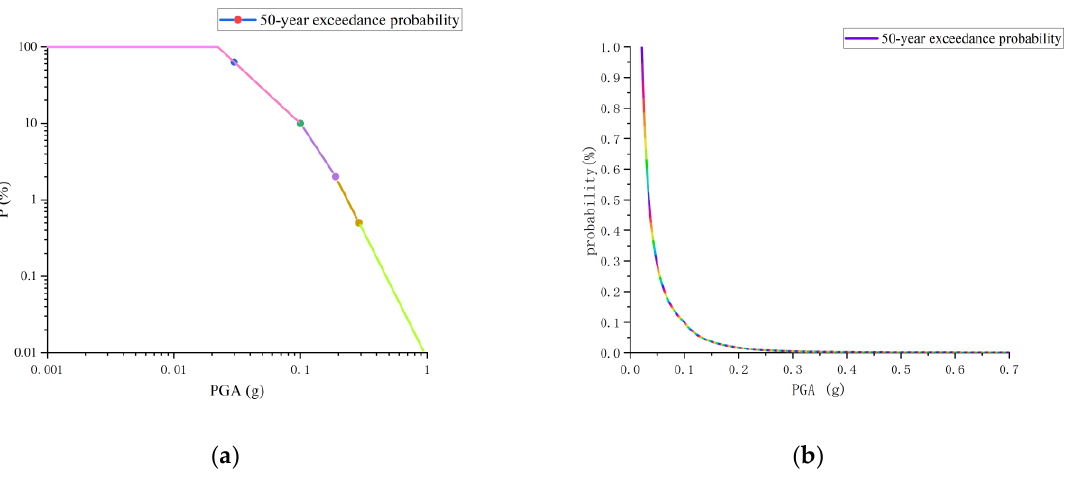
Figure 6. ( a ) Seismic hazard curve of the zone (logarithmic coordinates); ( b ) Seismic hazard curve of the zone (general coordinates).